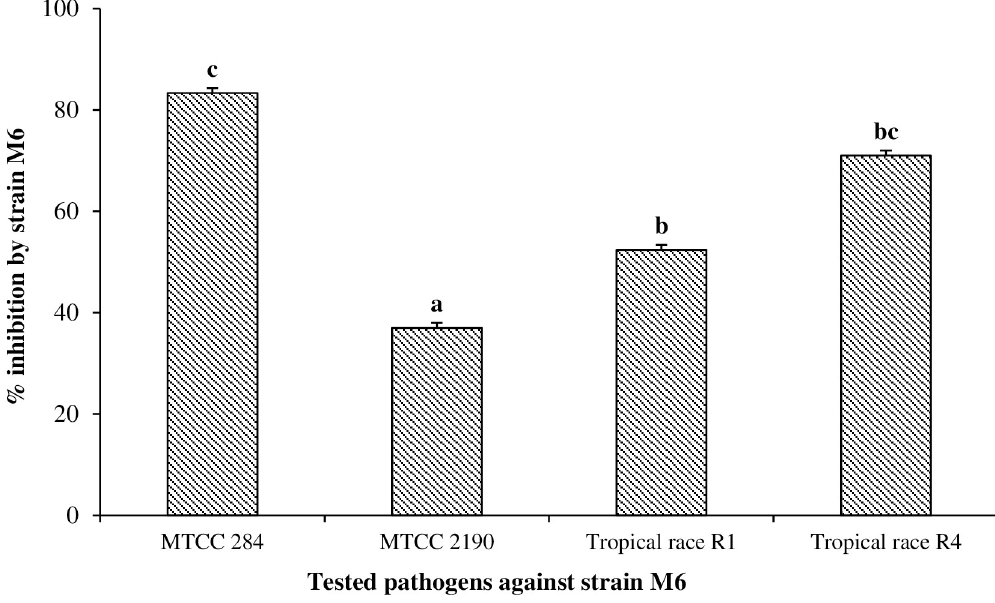
Fig 3. Biocontrol action of strain M6 against different plant